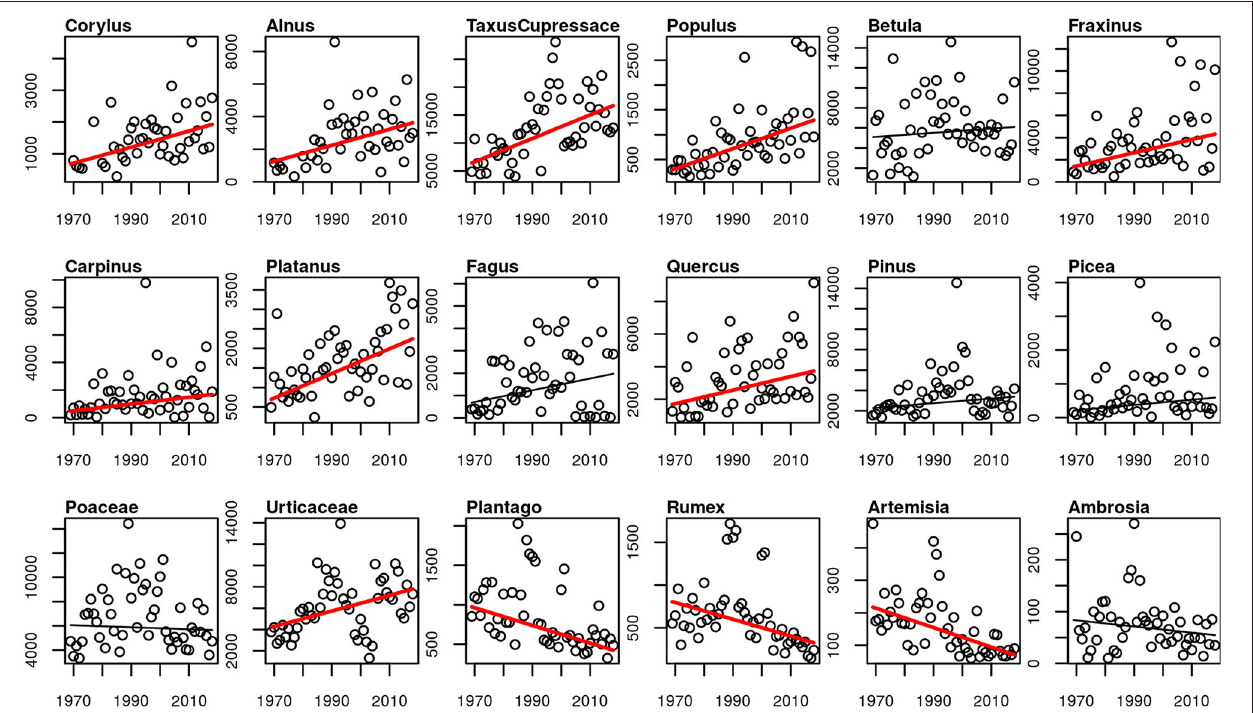
FIGURE 7 | Linear trends of APIn for the 50-year period 1969–2018. Red trend lines show significant trends ( p -value ≤ 0.05), black trend lines show non-significant trends.